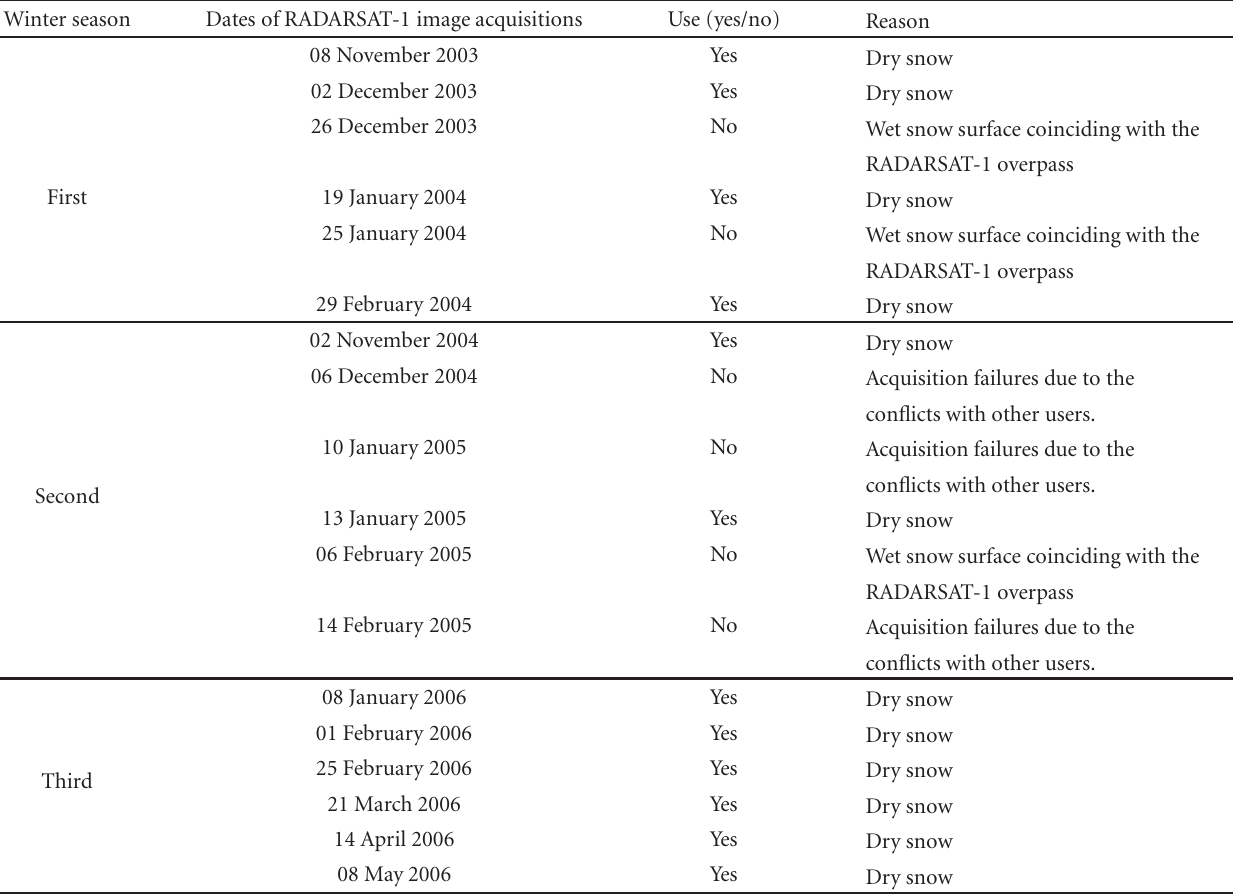
Table 3: Description of the RADARSAT-1 images acquired over the Bras d’Henri watershed during the three winter seasons (2003-2004 to 2005-2006) and the reasons for the use of only 12 radar images in this